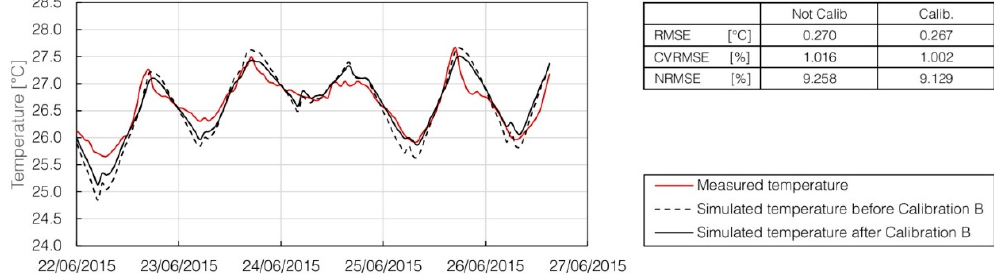
Figure 15. Effect of Calibration B on the temperature trend of the first floor, North exposure.